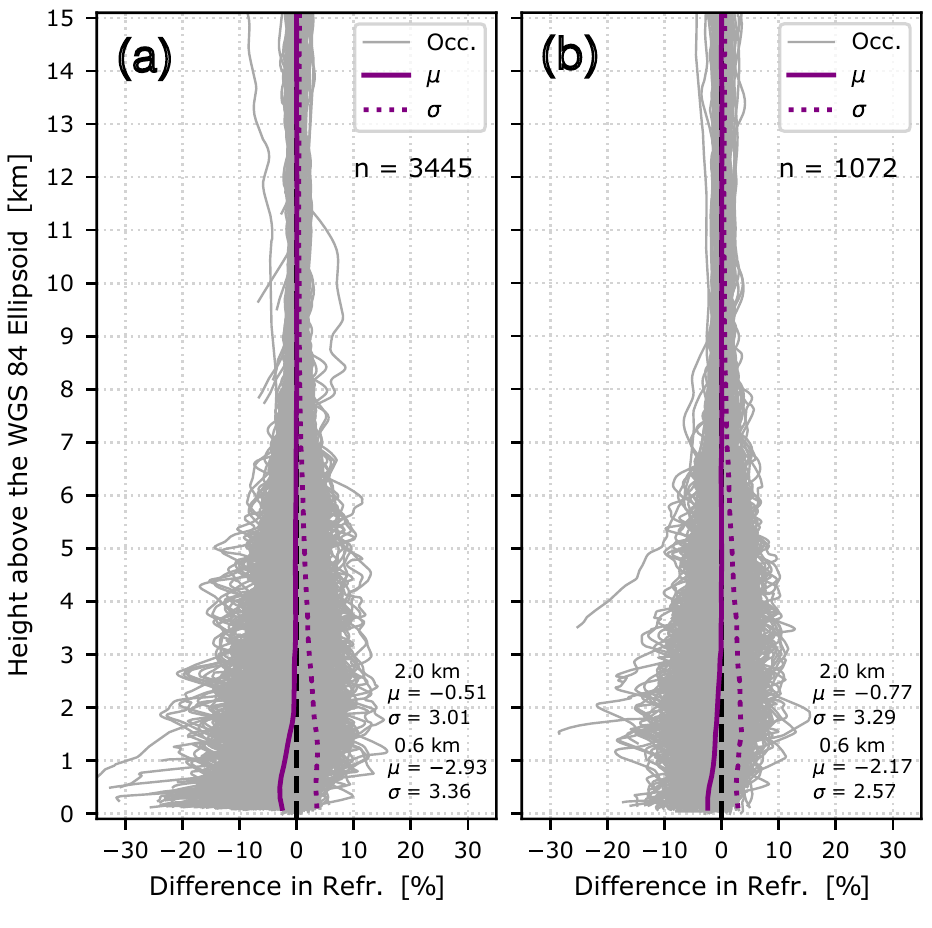
Figure 15. Statistical comparison between the COSMIC-2 dataset occultations (purple lines) during AR Recon that sampled ( a ) outside and ( b ) inside an atmospheric river and the ERA5 reanalysis product. Notation the same as Figure